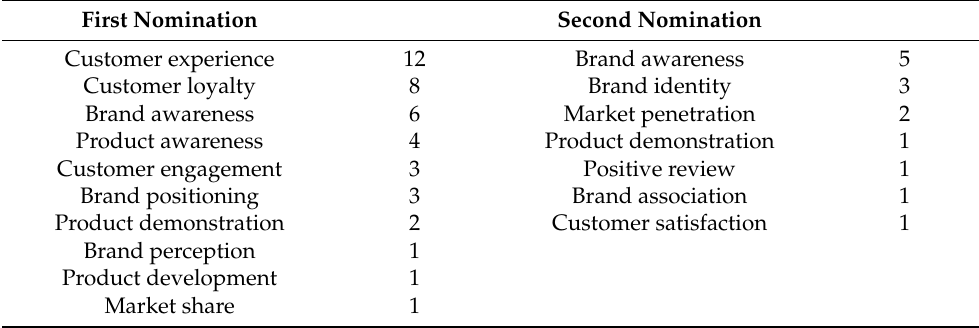
Table 2. Benefits of implementing experiential marketing strategy (n =